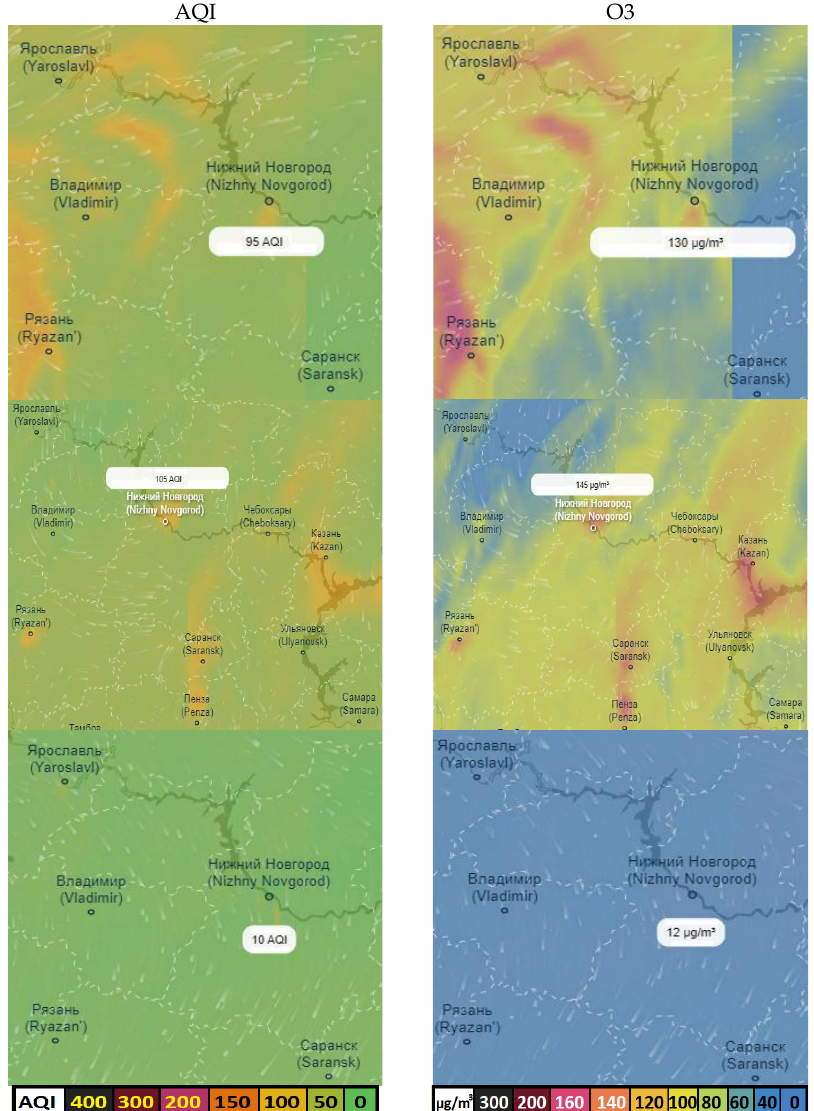
Figure 12. Spatial distribution of AQI (left column) and O3 (right column) for 27 July 2022 (first row), 8 August 2022 (second row), and 24 June 2022 (last row).